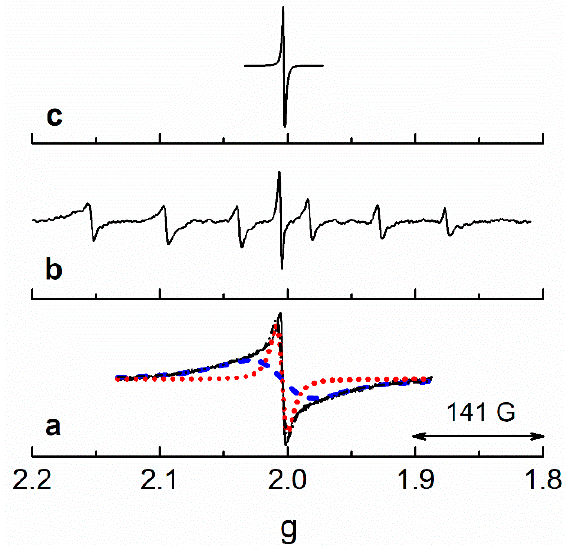
Figure 3. EPR spectra of samples wB ( a ), pB ( b ), and pAC_meso ( c ). In ( a ), the broad (blue dashed line) and the narrow (red dotted line) spectral components discussed in the text are also reported, together with their sum (black dashed dotted line). In ( b ) the displayed spectrum was baseline corrected, thus eliminating a broad component mentioned in the text.